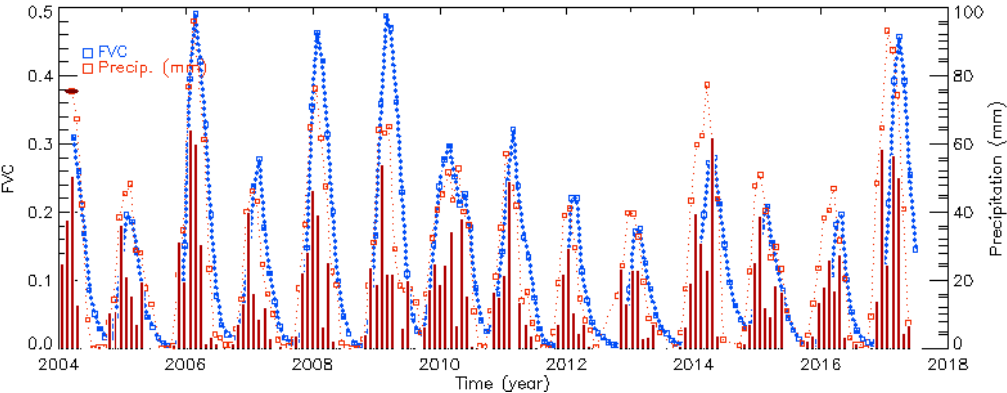
Figure 13. Time course of FVC and 3-month accumulated precipitation for an herbaceous region situated in Bostwana region (-23.1° N, 26.4° E).